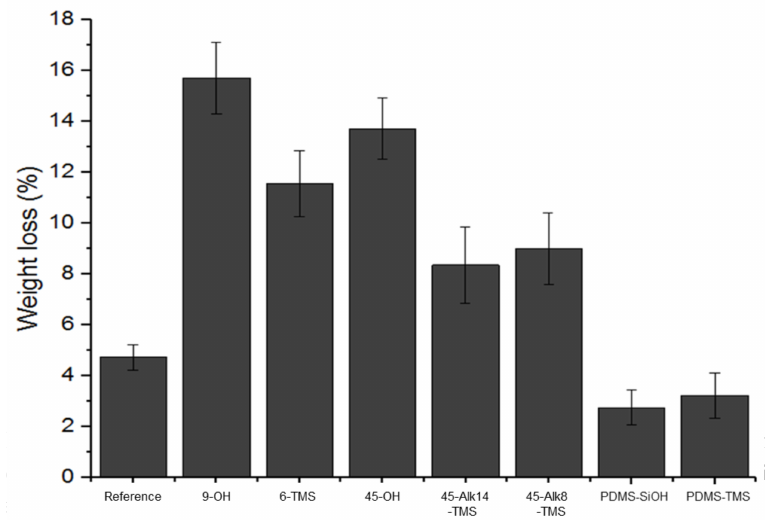
Figure 4. Uncross-linked materials and hydrophilic additives extracted from the film of PDMS 13